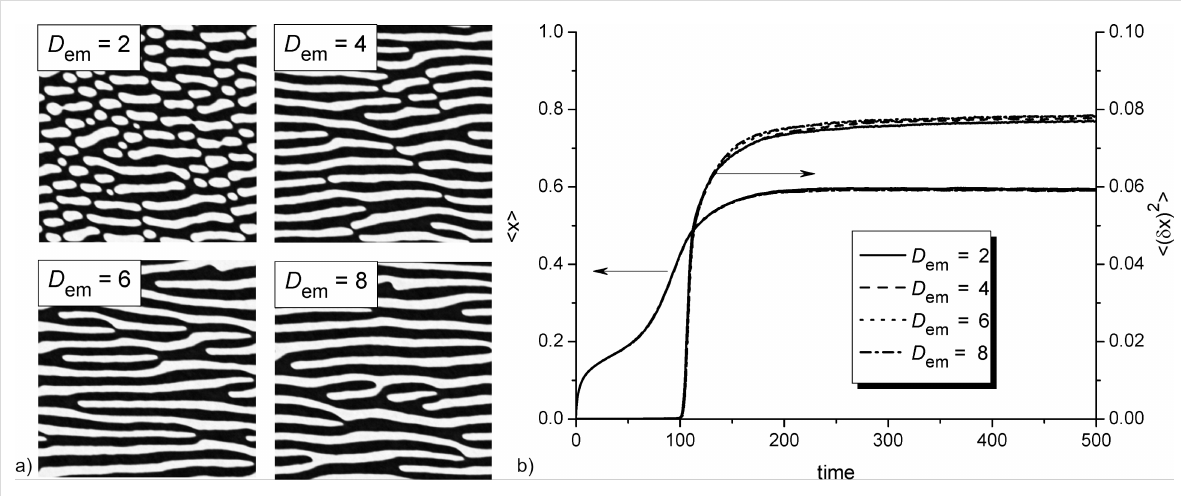
Figure 6: Typical snapshots of the quasistationary surface patterns for different values of the electrical field strength D em at k ∥ = 0.1 and α = 0.06 (a) and evolution of the mean adsorbate concentration ⟨ x ⟩ and the dispersion ⟨ ( δ x ) 2 ⟩ (b).